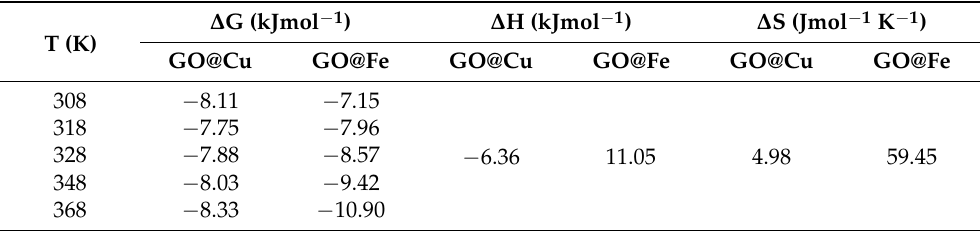
Table 4. Standard thermodynamic parameters for MB-dye removal from aqueous solution utilizing